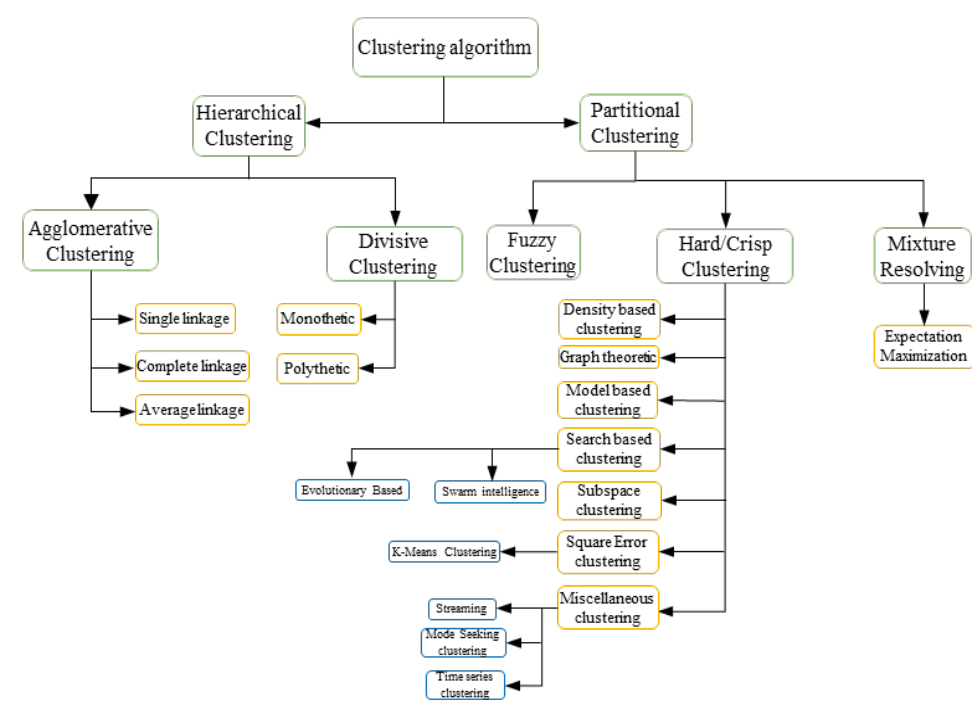
Figure 1. Taxonomy for various clustering techniques.